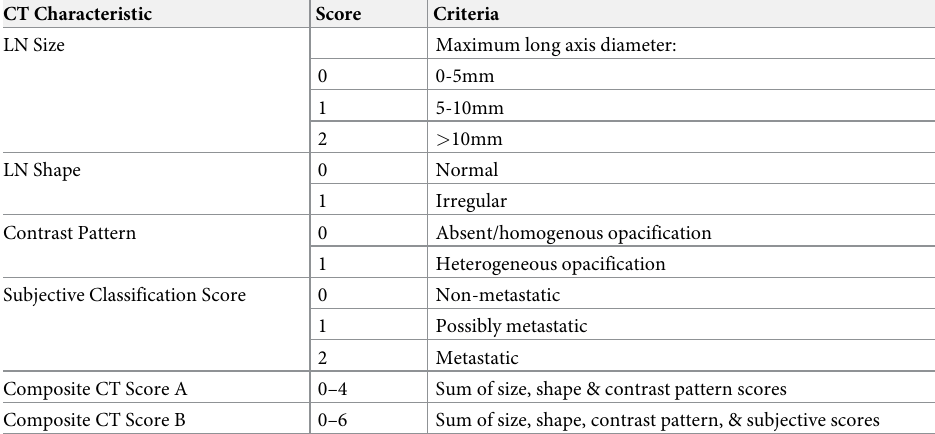
Table 1. Cervical LN classification for dogs with oral tumors on post-contrast CT.